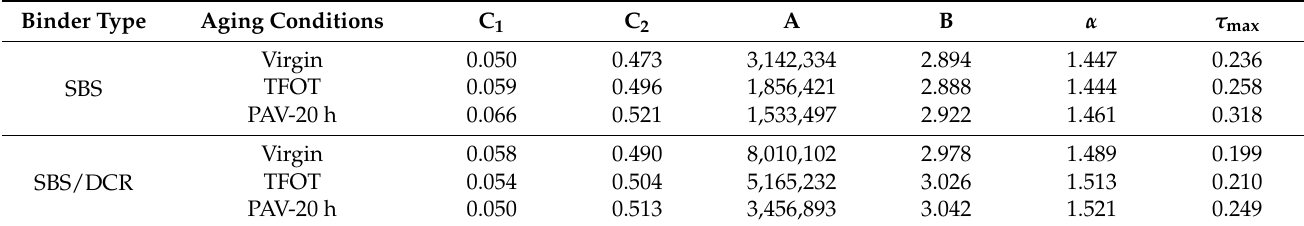
Table 3. Linear amplitude sweep test results of all tested binders based on viscoelastic continuum damage analysis. Binder Type Aging